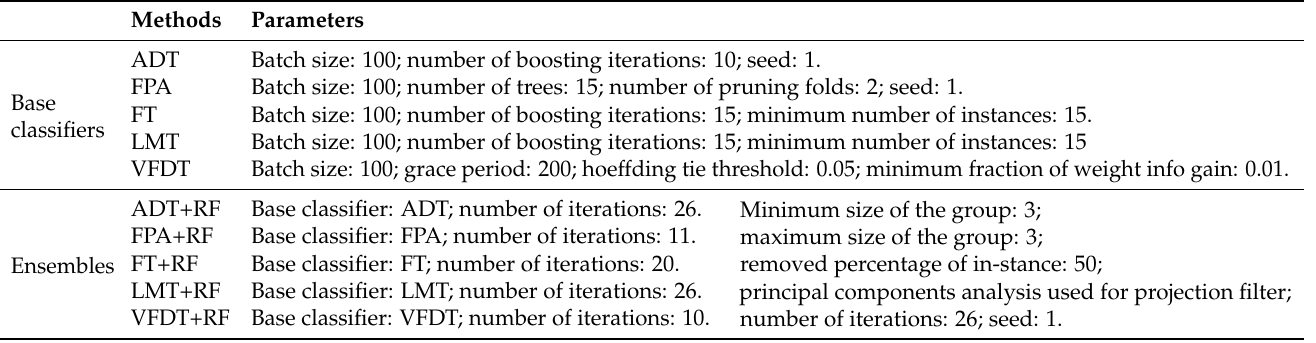
Table 2. Related parameters of the methods used in this study.